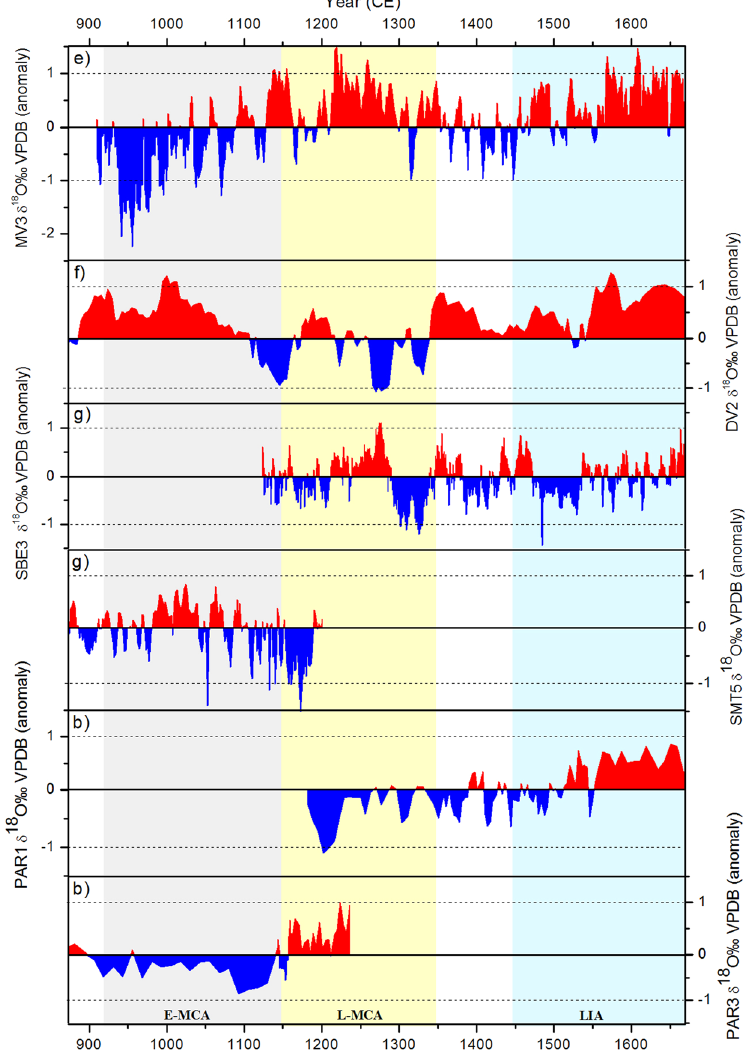
Figure 3. Comparison of δ 18 O anomalies from stalagmite records during the last millennium. Records include from top to bottom: ( e ) MV3 δ 18 O record– Eastern Cerrado (this study); ( f ) Diva de Maura Cave – DV2 δ 18 O record – Central-Eastern Brazil 53 ; ( g ) SBE3 – São Bernardo Cave and SMT5 – São Mateus Cave δ 18 O record – Central Brazil 16 ; ( b ) PAR1 and PAR3 – Paraiso Cave δ 18 O record – Eastern Amazon 9 . The anomalies were calculated subtracting the average δ 18 O isotope value from each